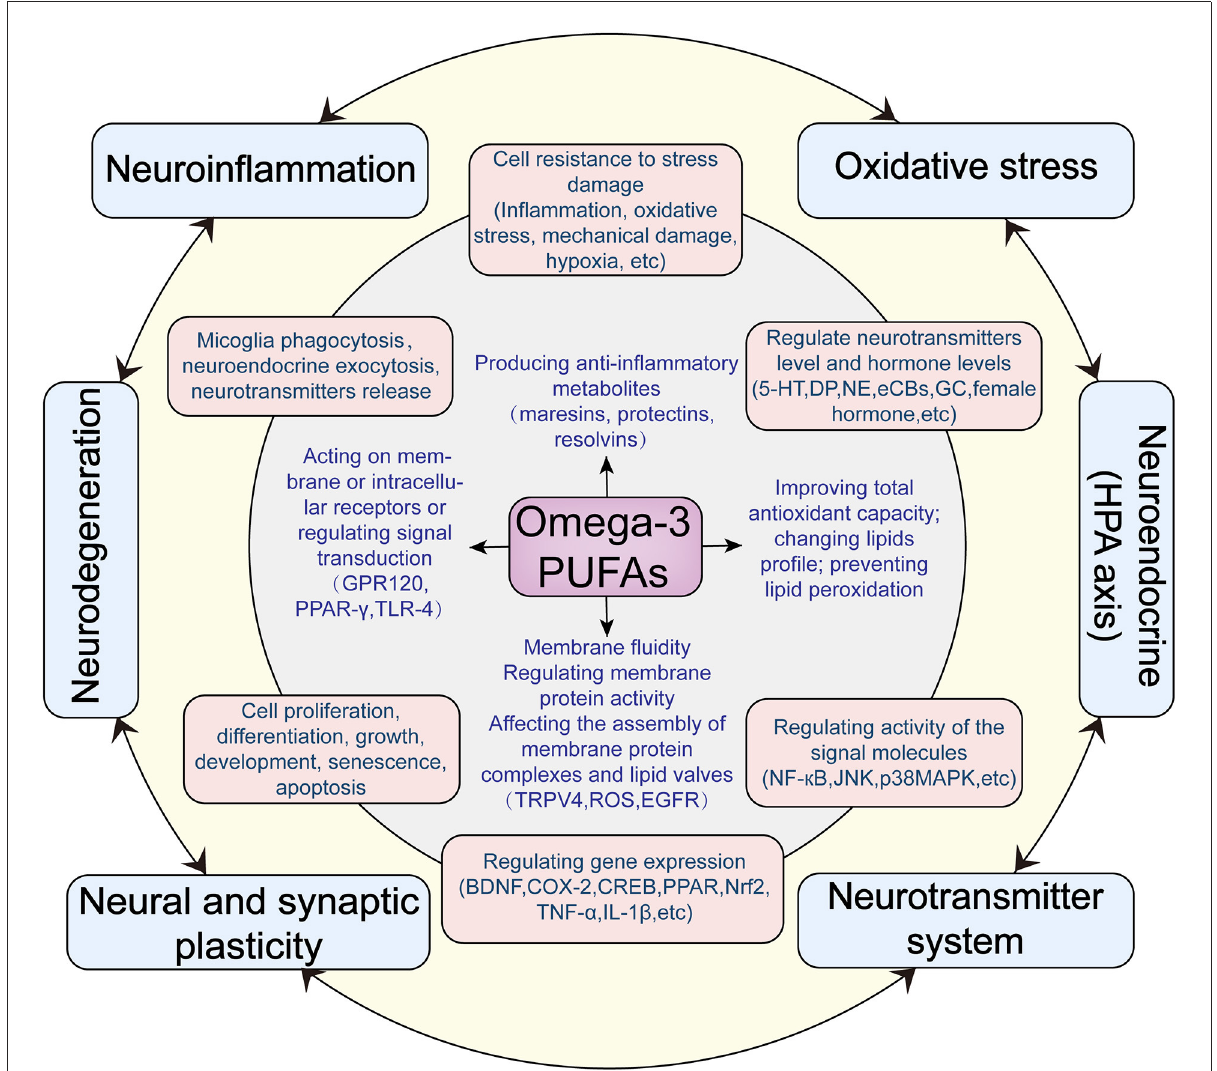
FIGURE1 Hypothesized antidepressant mechanisms of omega-3 PUFAs acting on the central nervous